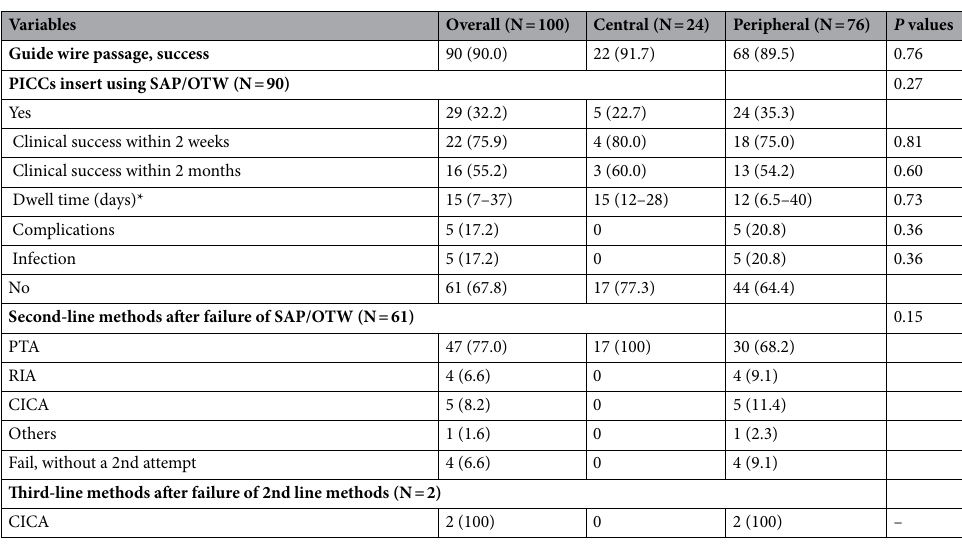
Table 2. Comparison of procedures used between central and peripheral VSOL groups (no. of procedures, n = 100). Data in parentheses are the percentages except for the dwell time. *Calculated using the Kaplan– Meier Methods. Data in parentheses are the